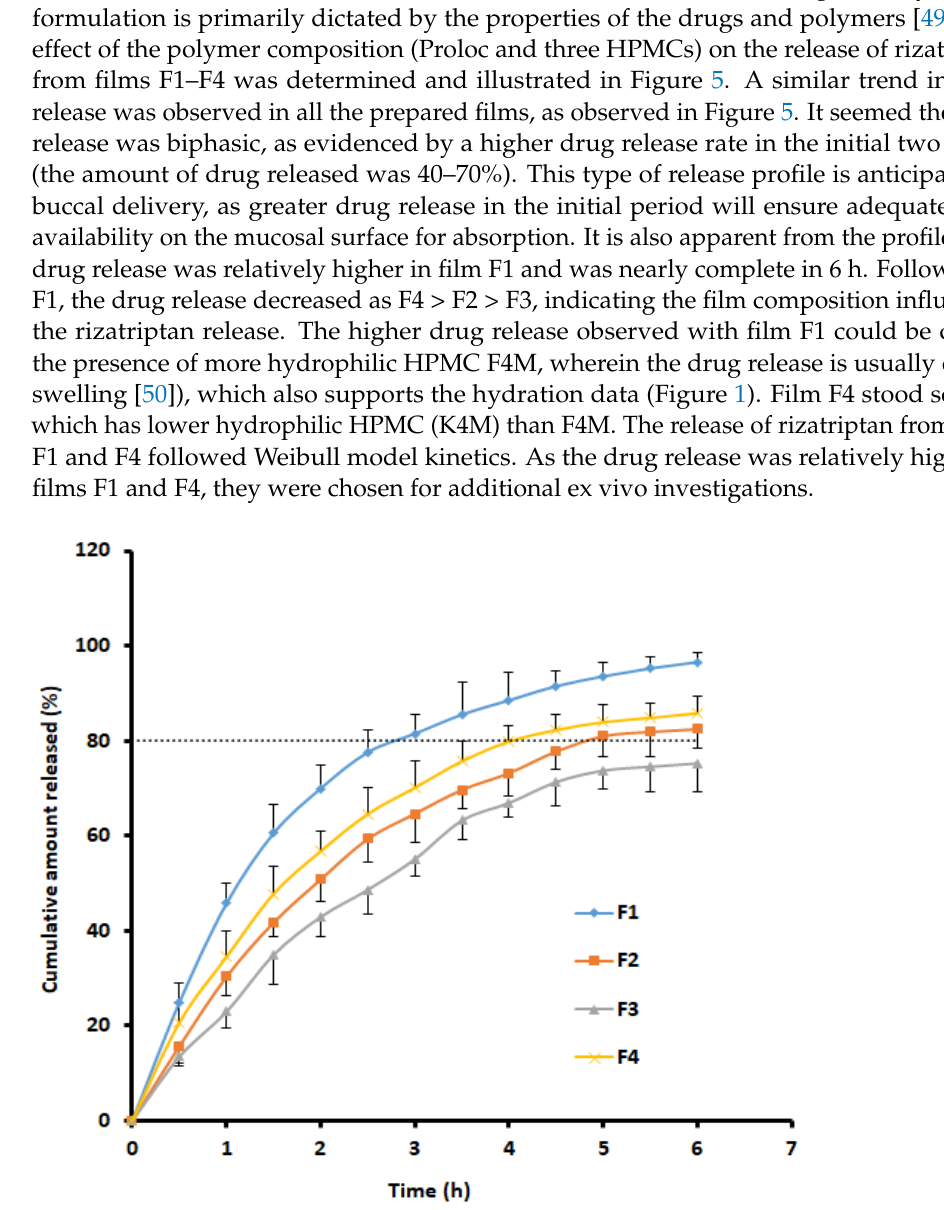
Figure 5. Cumulative percentage release of rizatriptan from buccal films (F1–F4). Data represented are mean ± SD ( n = 6).